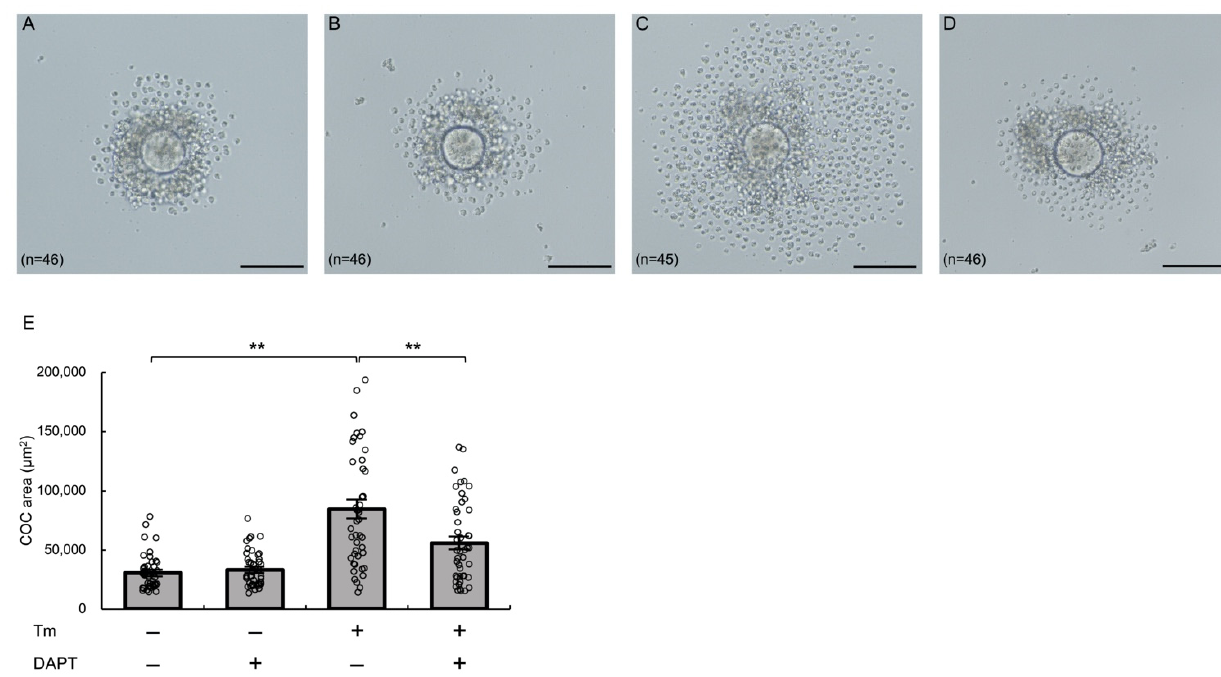
Figure 6. Notch signaling mediates ER stress-enhanced expansion of cultured murine COCs. COCs isolated from large antral follicles of PMSG-primed mouse ovaries were cultured in medium containing hCG (10 IU/mL) supplemented with tunicamycin (2.5 µg/mL) and/or DAPT (20 µM) for 15 h. ( A – D ) Representative microscopic images of COCs in each treatment group: ( A ) control, ( B ) DAPT, ( C ) tunicamycin, and ( D ) tunicamycin + DAPT. The scale bars indicate 100 µm. ( E ) Quantitative analysis of the areas of COCs. Values represent means ± SEM. ** p < 0.01. Tm, tunicamycin.